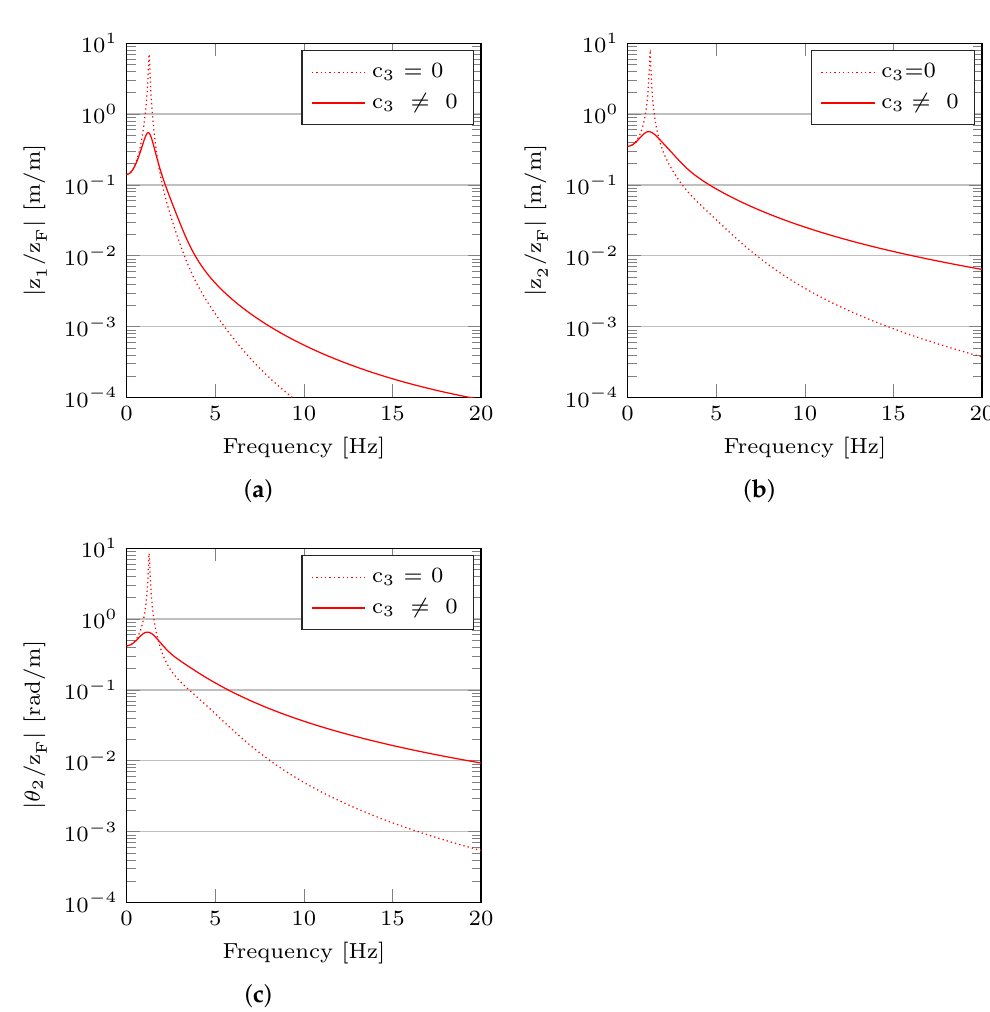
Figure 7. Transmissibility between the vertical displacement of the tractor front wheels and: ( a ) the vertical displacement of the operator’s seat z 1 / z F ; ( b ) the vertical displacement of the tractor frame z 2 / z F ; ( c ) the rotation of the tractor frame θ 2 / z F